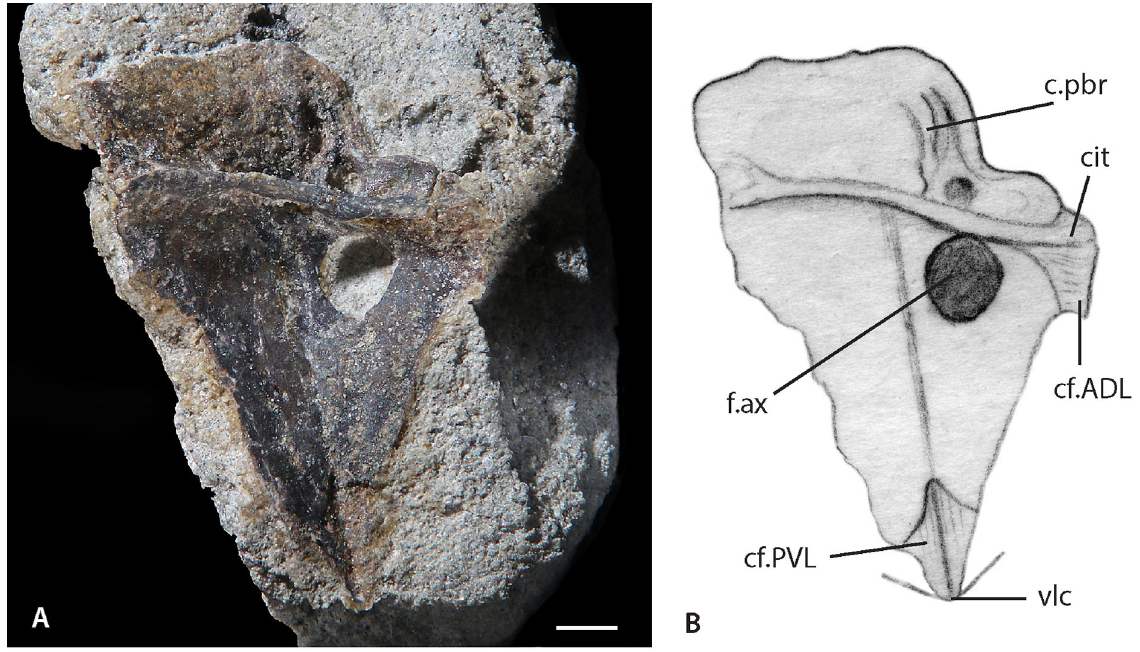
Fig. 8. Microbrachius kedoae from the Gavrilchitsy 45 borehole . GIT 767-12, an anterior ventro-lateral plate in visceral view. Scale bar = 1 mm. Abbreviations: ADL, anterior dorso-lateral plate; PVL, posterior ventro-lateral plate; cf.ADL, area overlapping ADL, cf.PVL, area overlapping PVL; cit, crista transversalis interna anterior; c.pbr, crista postbranchialis; f.ax, axillary foramen of anterior ventro-lateral plate; vlc, ventro-lateral